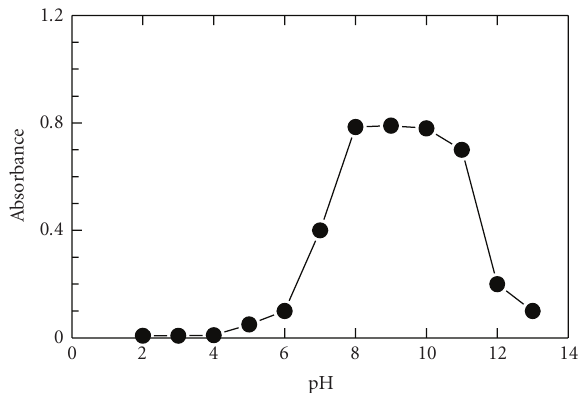
Figure 3: E ff ect of pH on the reaction of PRX with NQS. PRX (40 μ gmL − 1 ): 1mL; Clark and Lubs bu ff er solution: 1 mL; NQS (0.5%, w/v): 1mL; temperature: 25 ± 5 ◦ C; reaction time: 10